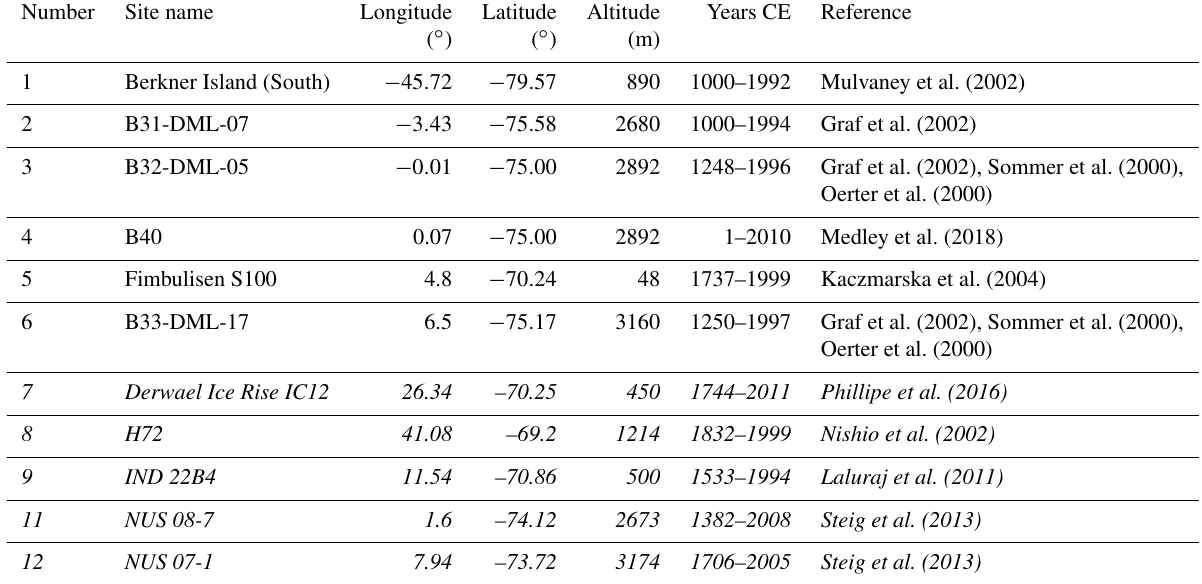
Table 1. Ice core records used in this study (based on Medley and Thomas, 2019, and Stenni et al., 2017a). The surface mass balance from the first six records are used in the reconstructions of the polynya activity. The other records (in italic) are only displayed in Figs. 2 and